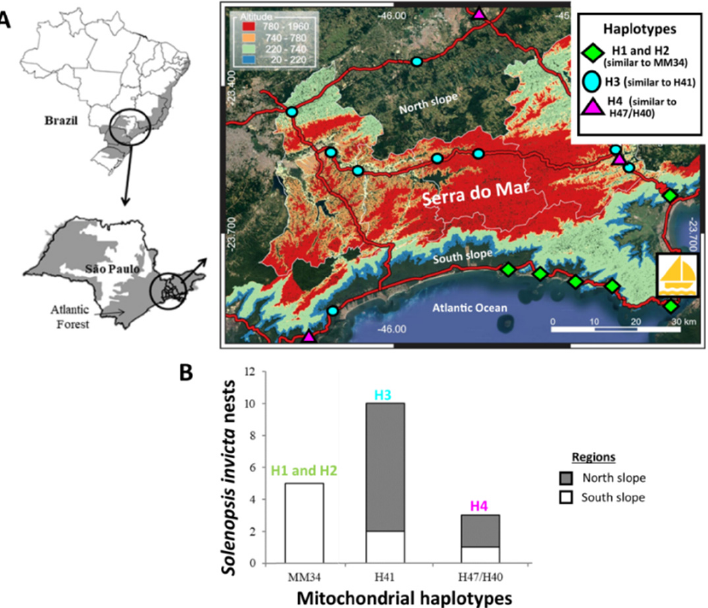
Figure 1. mtDNA COI haplotypes of Solenopsis invicta sampled from the north and south faces of the Serra do Mar Mountain range in the state of São Paulo, Brazil. ( A ) Map with sampled haplotype’s locations. Red lines indicate the highways used for collections. The elevational gradient in Serra do Mar is indicated by colors, where red corresponds to the highest elevations. A marine port (São Sebastião) is indicated by a yellow boat. ( B ) Distribution of the mitochondrial COI haplotypes obtained.